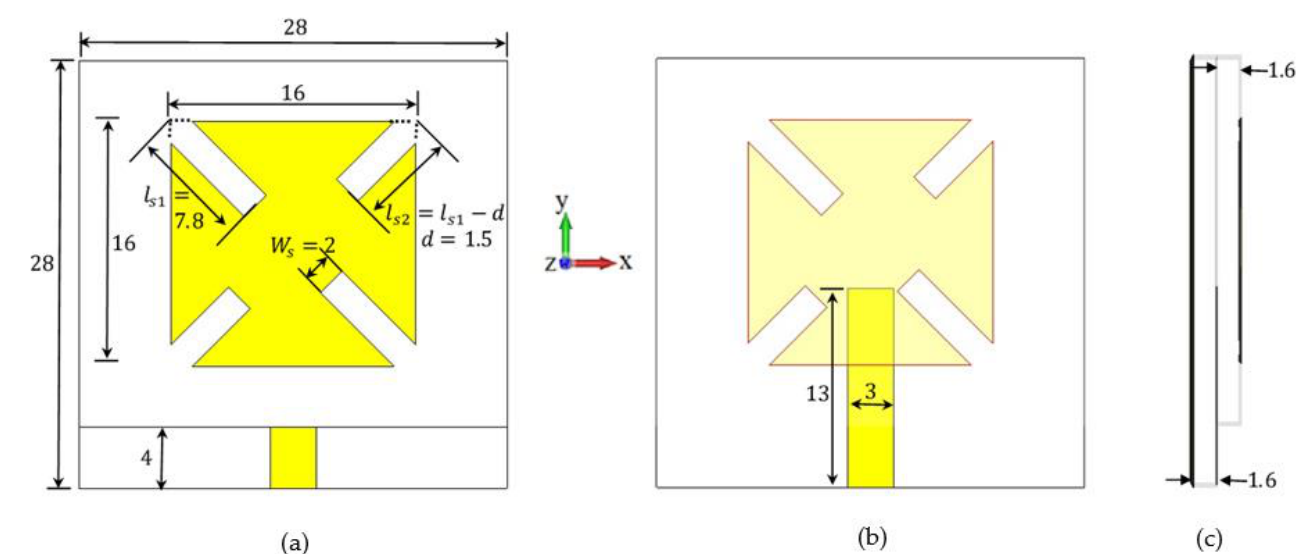
Figure 1. The structure of the proposed single-element CP antenna with two unequal pairs of slits with its optimized parameter values ( a ) top view, ( b ) the feed line structure, and ( c ) the side view. (All dimensions are in mm).